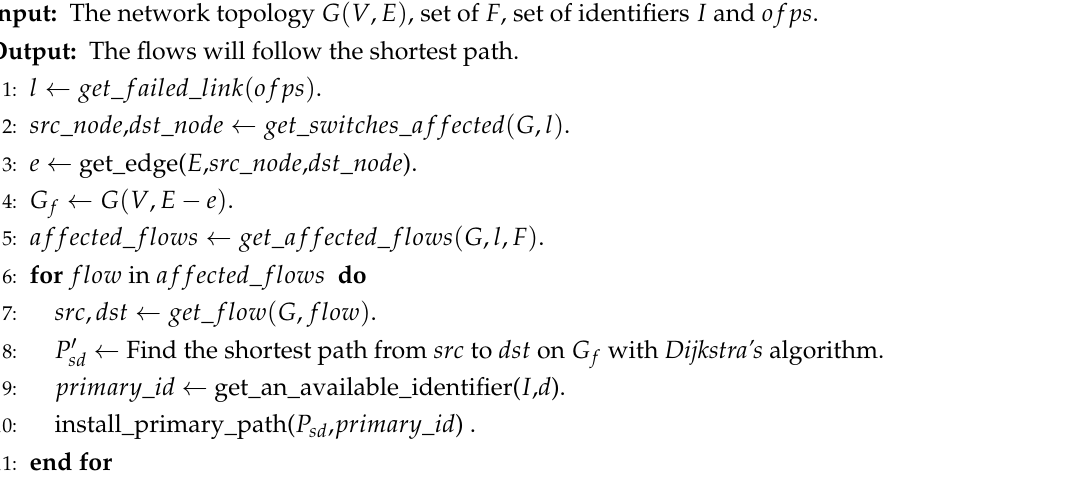
Algorithm 4 The algorithm of LONG for the restoration